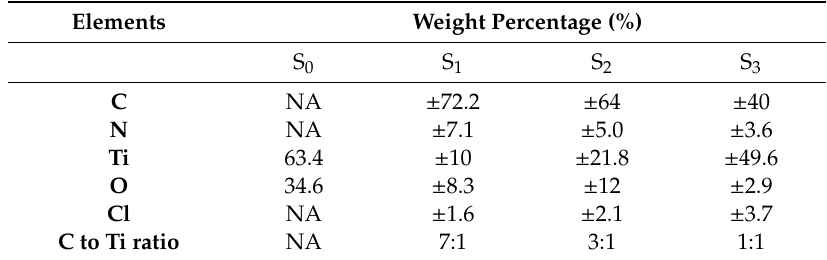
Table 3. Weight percentage as derived TEM-energy-dispersive spectroscopy (TEM-EDS) of the synthesised nano catalysts pyrolysed at 350 ◦ C using a 50 ◦ C / min ramping rate and holding times